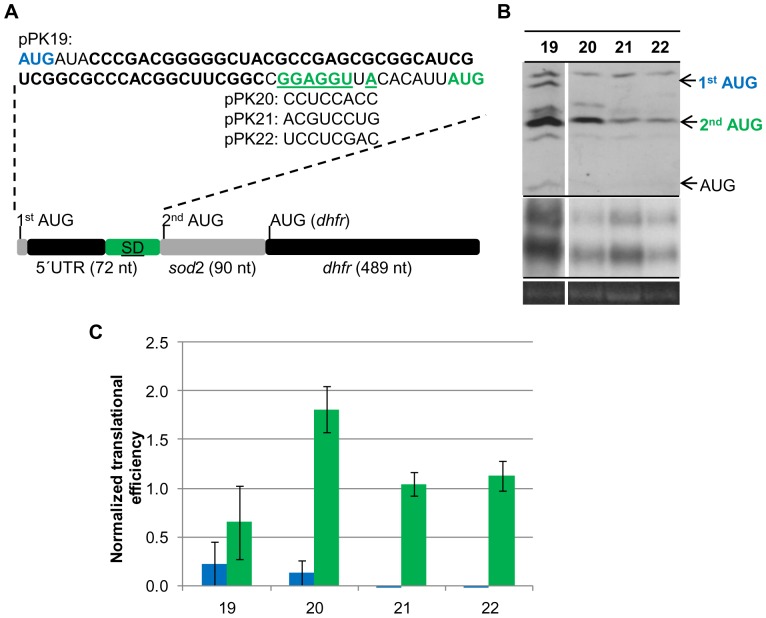
Translational efficiencies of different transcripts with and without an SD sequence.For the comparative analysis of translational efficiencies H. volcanii cultures of pPK19-pPK22 were grown to mid-exponential growth phase under standard conditions. A. Schematic overview of the reporter gene constructs pPK19-pPK22. The native SD motif of the sod gene (green and underlined) was replaced by three randomly generated unrelated sequences in the mutants pPK20-pPK22. A second leaderless translation start site AUG was introduced at the 5′-end of the 51 nt elongated sod 5′-UTR (blue). B. One representative example of three independent experiments is shown for a Western blot analysis (upper panel), a Northern blot analysis (middle panel), and the 16S rRNA of an agarose gel used for normalization. The protein and transcript levels were analyzed as described in Experimental Procedures. The results are summarized in Table S5. C. Graphic representation of the normalized average translational efficiencies and their standard deviations (n = 3). Results of proteins originating from the leaderless start codon are shown in blue, results of proteins originating from the sod start codon are shown in green.